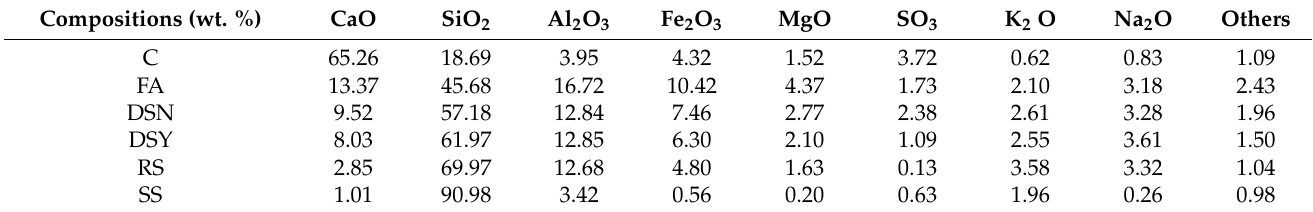
Table 1. Chemical compositions of raw materials.